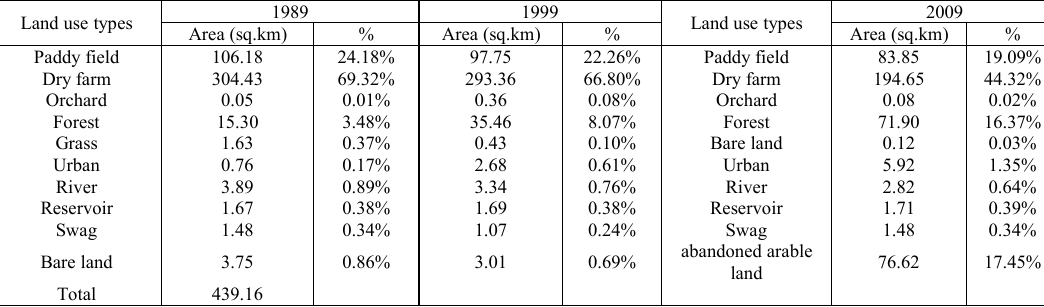
Table 2 Results of land use / land cover classification for 1989, 1999 and 2009 images. Showing the study area of each category and